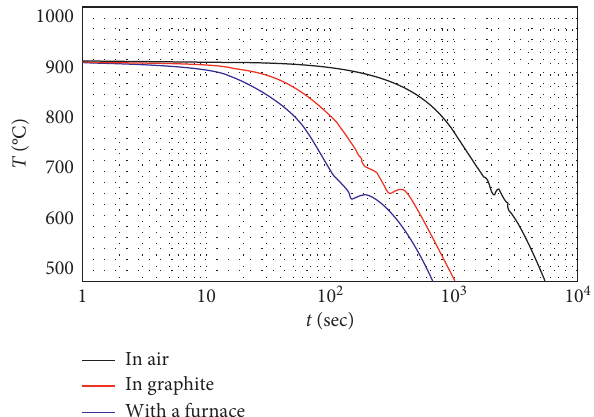
Figure 14: Temperature change of deposited steel S 45 samples with a 20mm diameter under various cooling conditions after heat treatment [17].